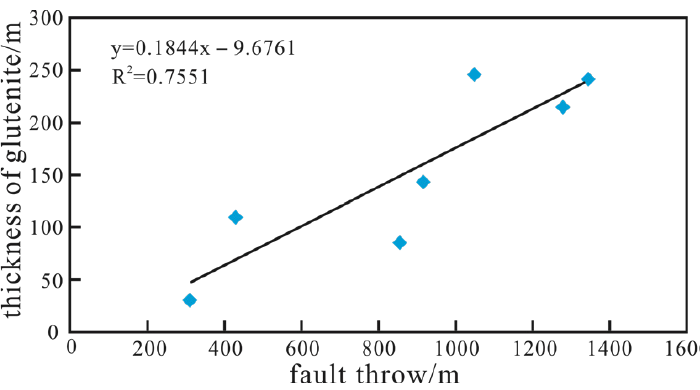
Figure 8. The relationship between the fault throw and the thickness of a glutenite body.